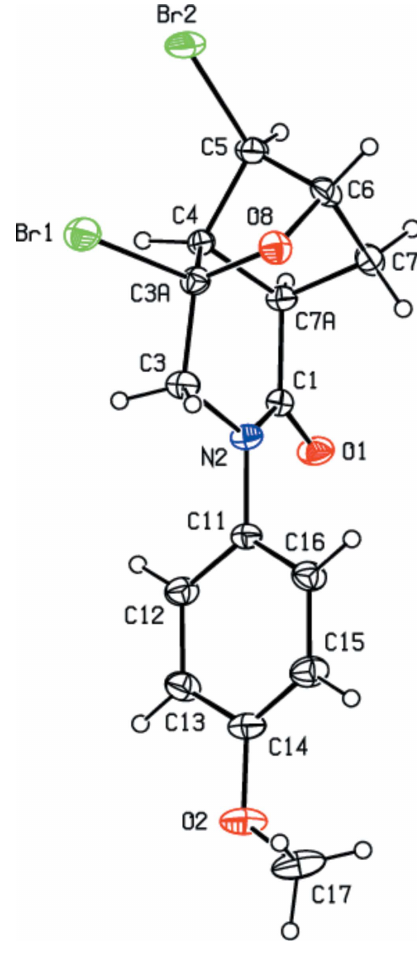
Figure 2 The molecular structure of 2 , with displacement ellipsoids for non- hydrogen atoms drawn at the 30% probability level.